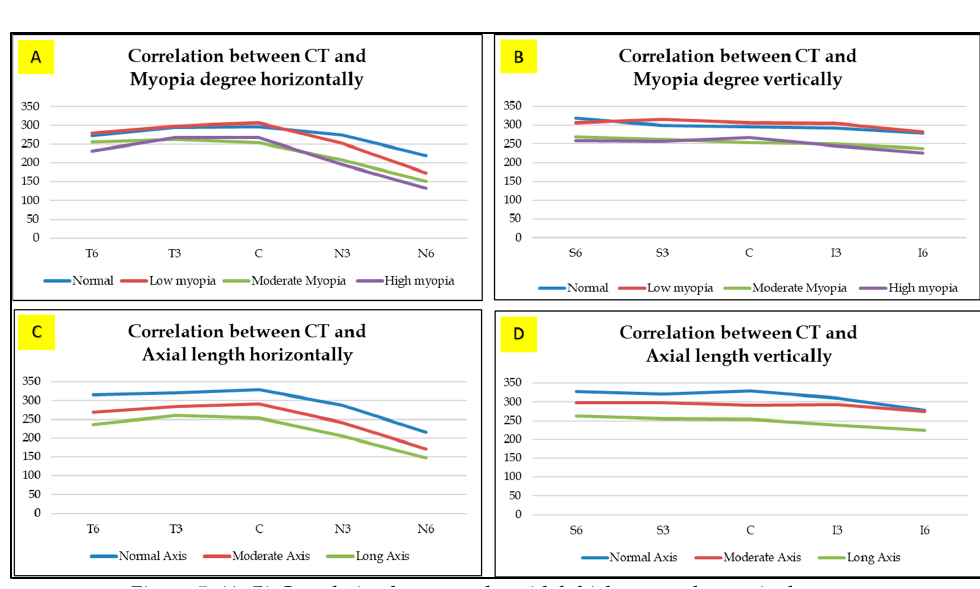
Figure 5. (A, B) Correlation between choroidal thickness and myopia degree (C, D) Correlation between choroidal thickness and axial length. Figure 5. ( A , B ) Correlation between choroidal thickness and myopia degree. ( C , D ) Correlation between choroidal thickness and axial